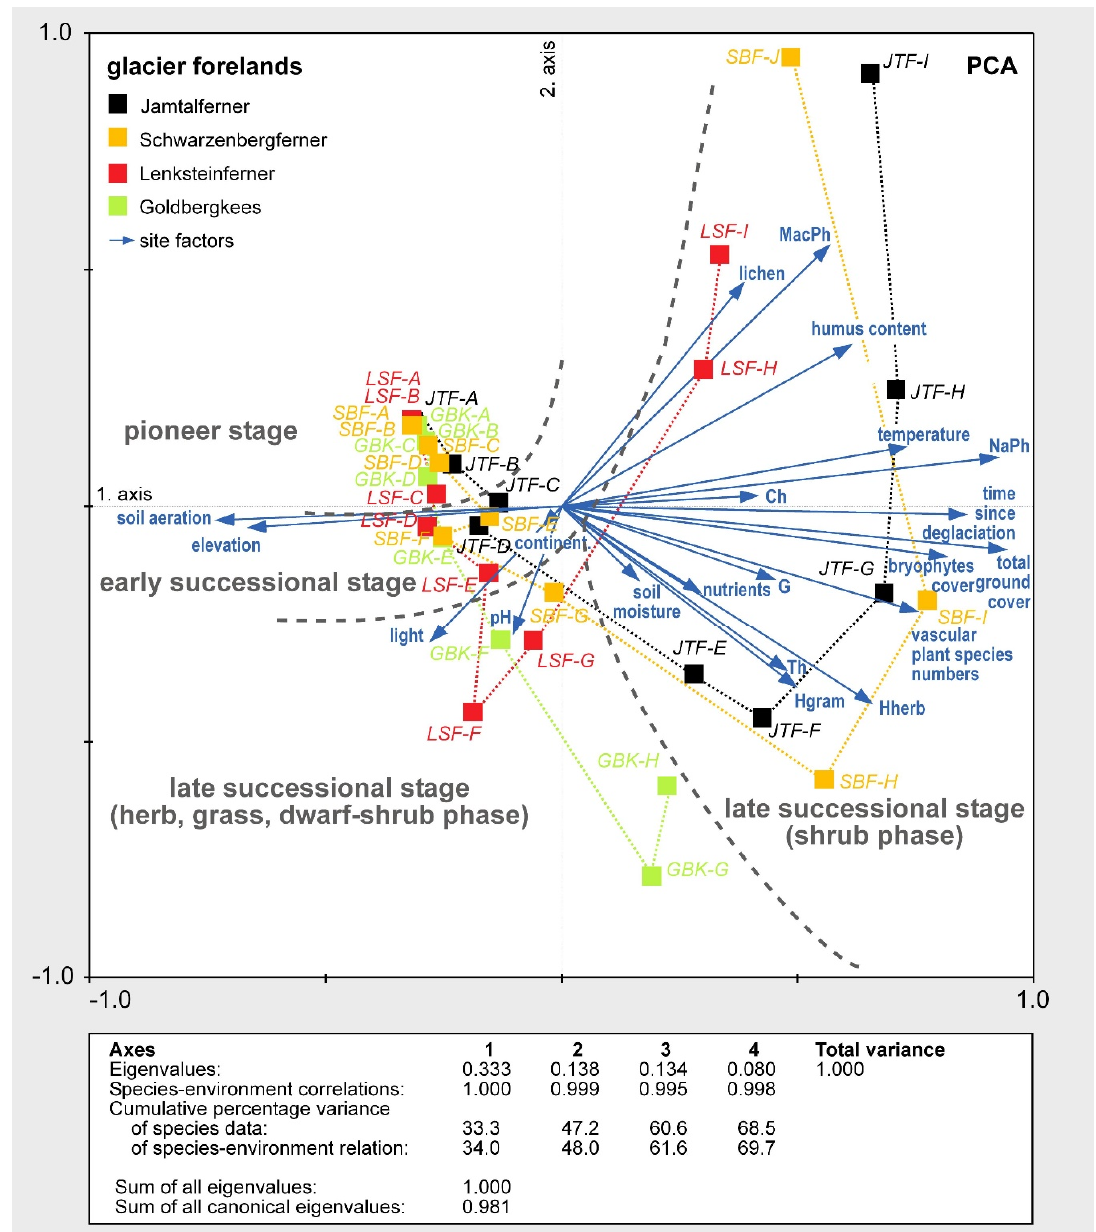
Figure 7. Principal component analysis (PCA) scatter plot of the sample locations (mean out of three sample sites) in the different glacier forelands based on species composition, considering respective ground cover values.